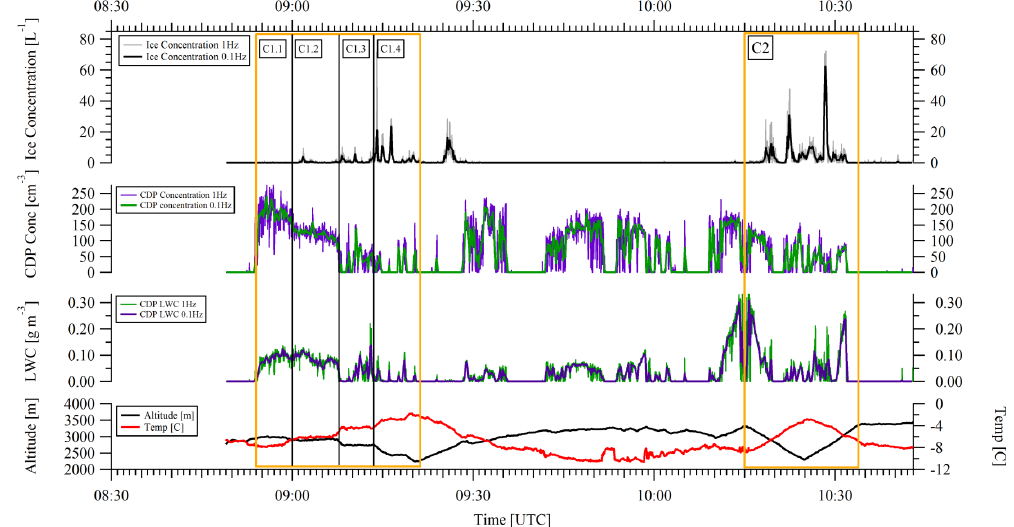
Figure 6. Microphysics time series data for summer case 1. Data includes temperature ( ◦ C) and altitude (m) (lower panel) together with 1 and 10s data sets for CDP liquid water content (gm − 3 ) (second panel up), CDP concentrations (cm − 3 ) , ice water content (gm − 3 ) and ice number concentrations (L − 1 ) (top panels). Flight segments C1.1, C1.2, C1.3 and C1.4 are described in the